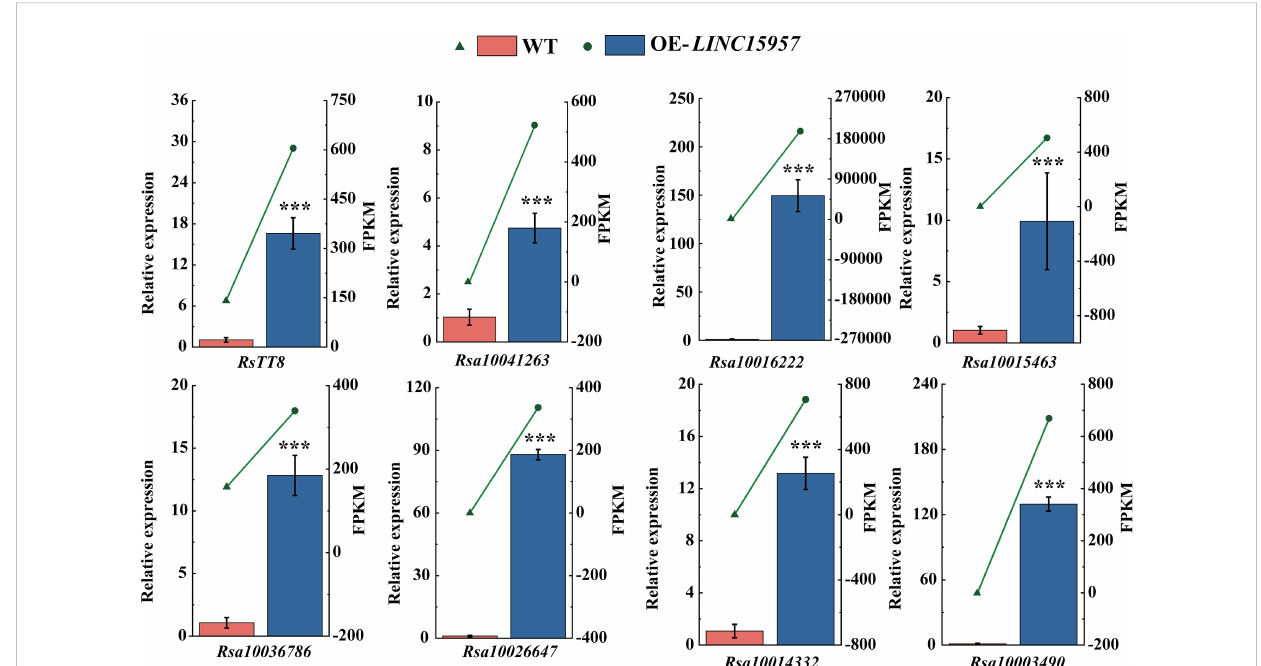
FIGURE 6 The genes related to anthocyanin biosynthesis in OE- LINC15957 were analyzed by RT-qPCR. Relative gene expression levels were standardized relative to actin transcription levels. Error bars represent the mean ± SE of three biological replicates. ***p < 0.001, Student ’ s